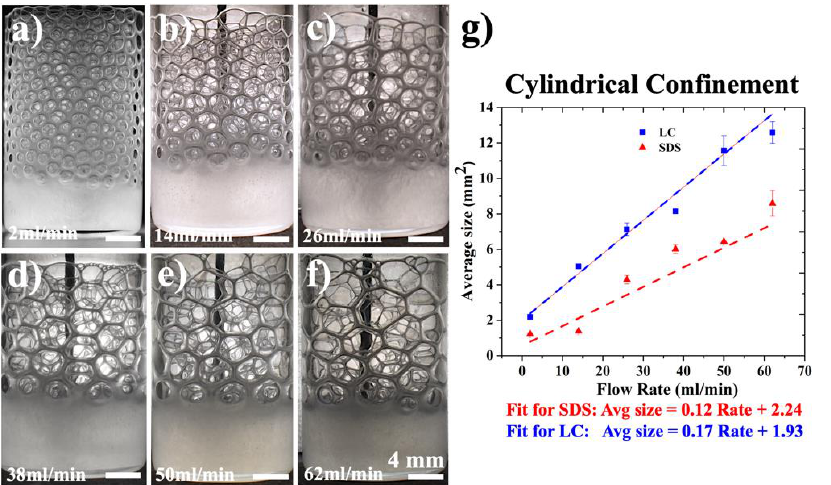
Figure 4. Fabrication of smectic foam under cylindrical confinement. The cylindrical containers are glass vials with a base area of 230 mm 2 . Images of LC foams created at an airflow rate of ( a ) 2 mL/min, ( b ) 14 mL/min, ( c ) 26 mL/min, ( d ) 38 mL/min, ( e ) 50 mL/min, and ( f ) 62 mL/min. ( g ) Average area of the foam cells near the container’s wall for LC (squares) and SDS (triangles) as a function of the airflow rate.